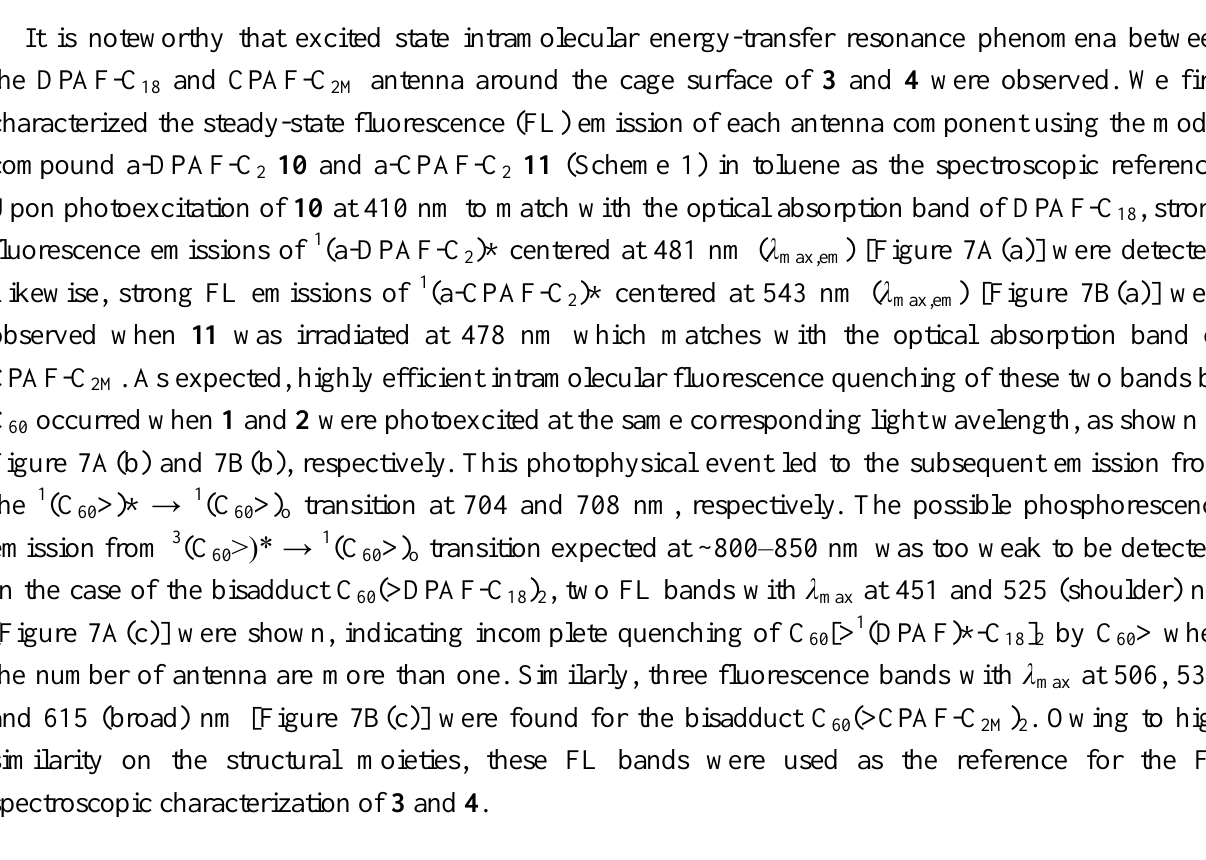
8 , ( b ) BrCPAF-C 9 , ( c ) C (>CPAF-C 18 2M 60 )(>CPAF-C ) 3 , ( f ) C (>DPAF-C )(>CPAF-C 18 2M 60 18